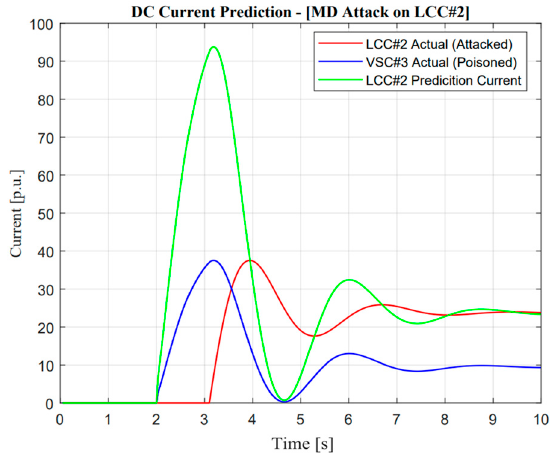
Figure 16. DC current prediction in missing data attack operation.